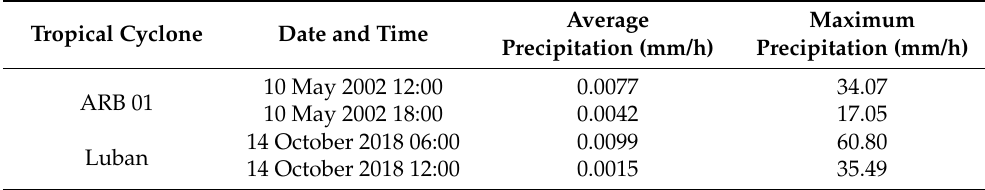
Table 2. Average precipitation rate and maximum precipitation rate in a radius range of 400 km of the TC central